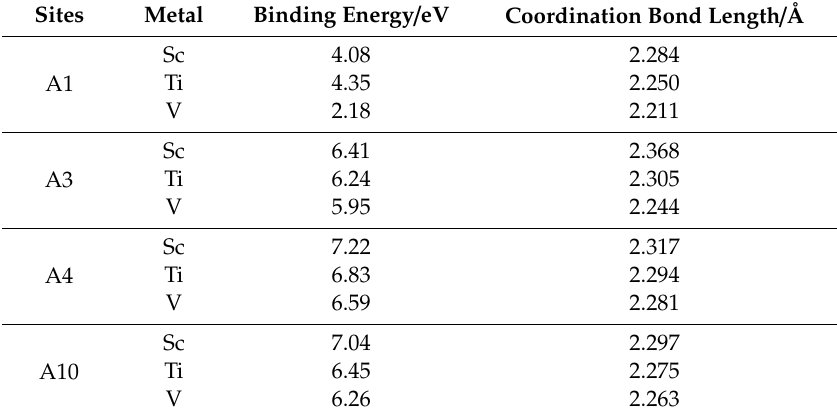
Table 1. The binding energies and coordination bond lengths of Sc, Ti and V atoms being adsorbed on ZTC at various